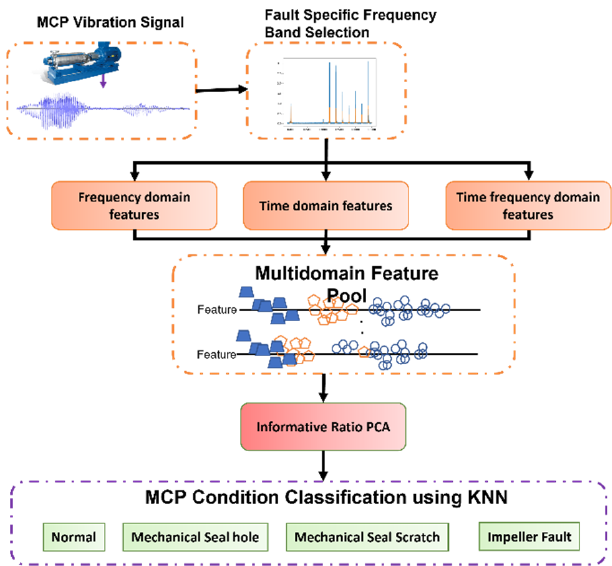
Figure 5. Proposed method for MCP condition monitoring.